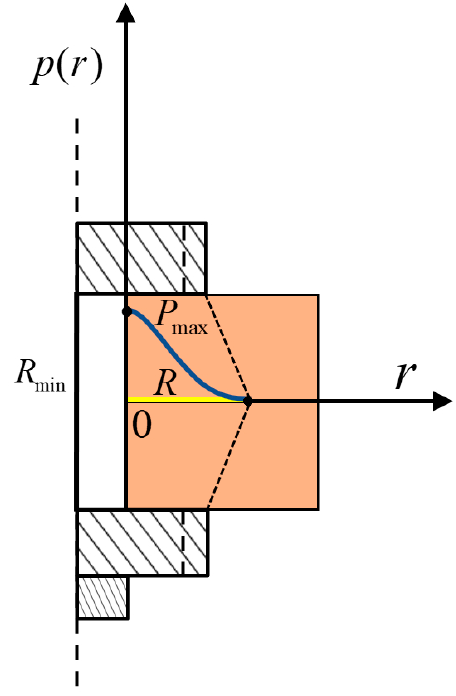
Figure 4. Schematic diagram of Fernlund pressure distribution.